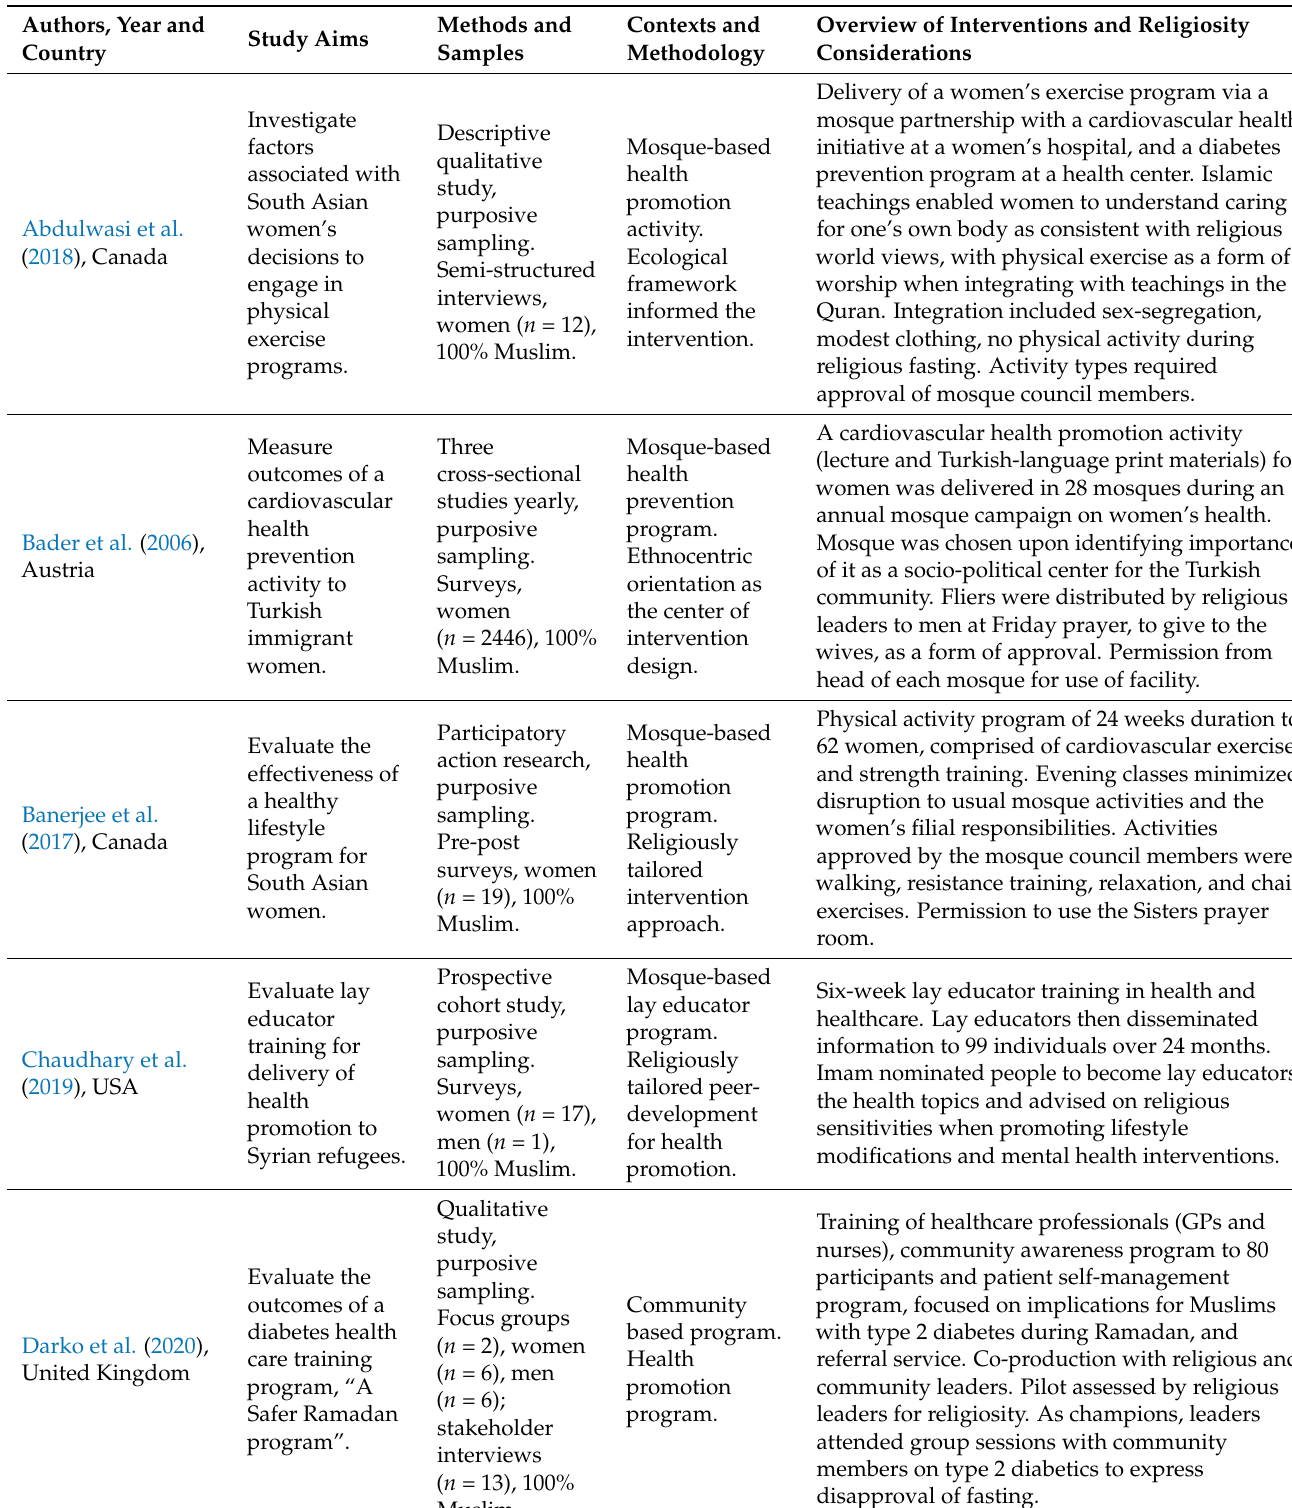
Table 1. Summary of studies